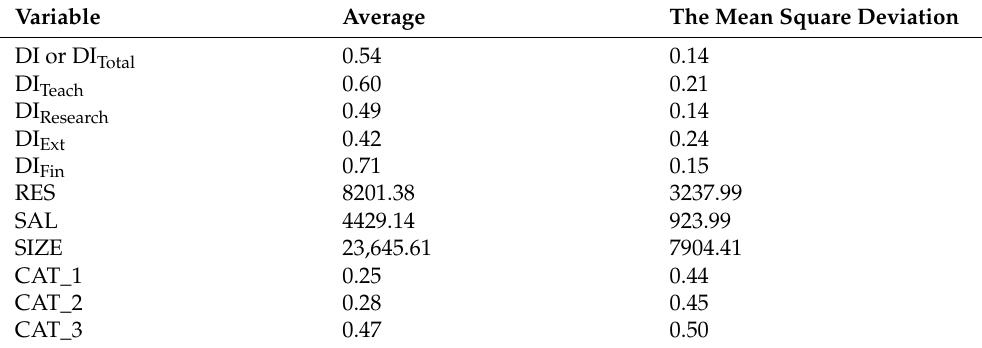
Table 2. Variables’ descriptive statistics.